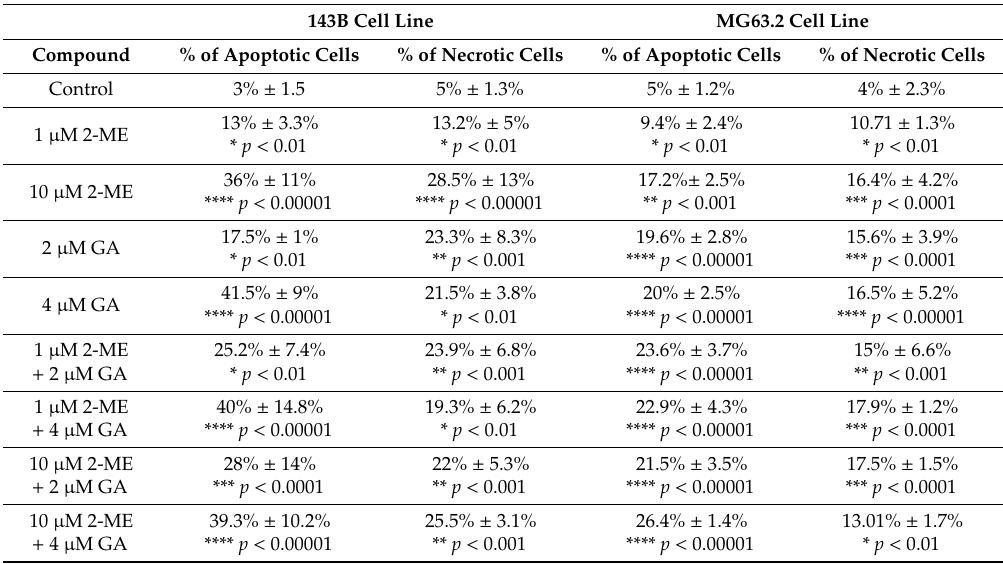
Table 1. Antagonistic e ff ects of 2-ME and GA in 143B and MG63.2 cell lines.